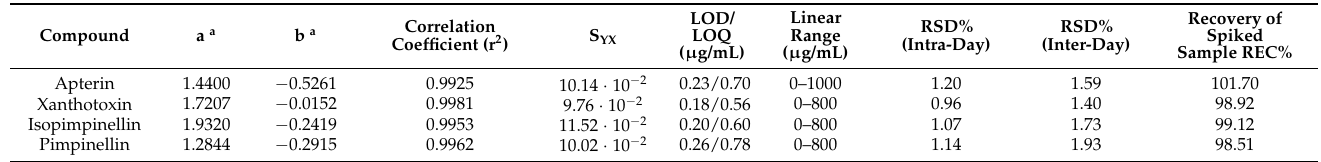
Table 3. Regression equations, correlation coefficients (r 2 ), standard deviation ( S YX ), limits of detec- tion (LOD), limits of quantification (LOQ), and linear ranges for four reference standards.